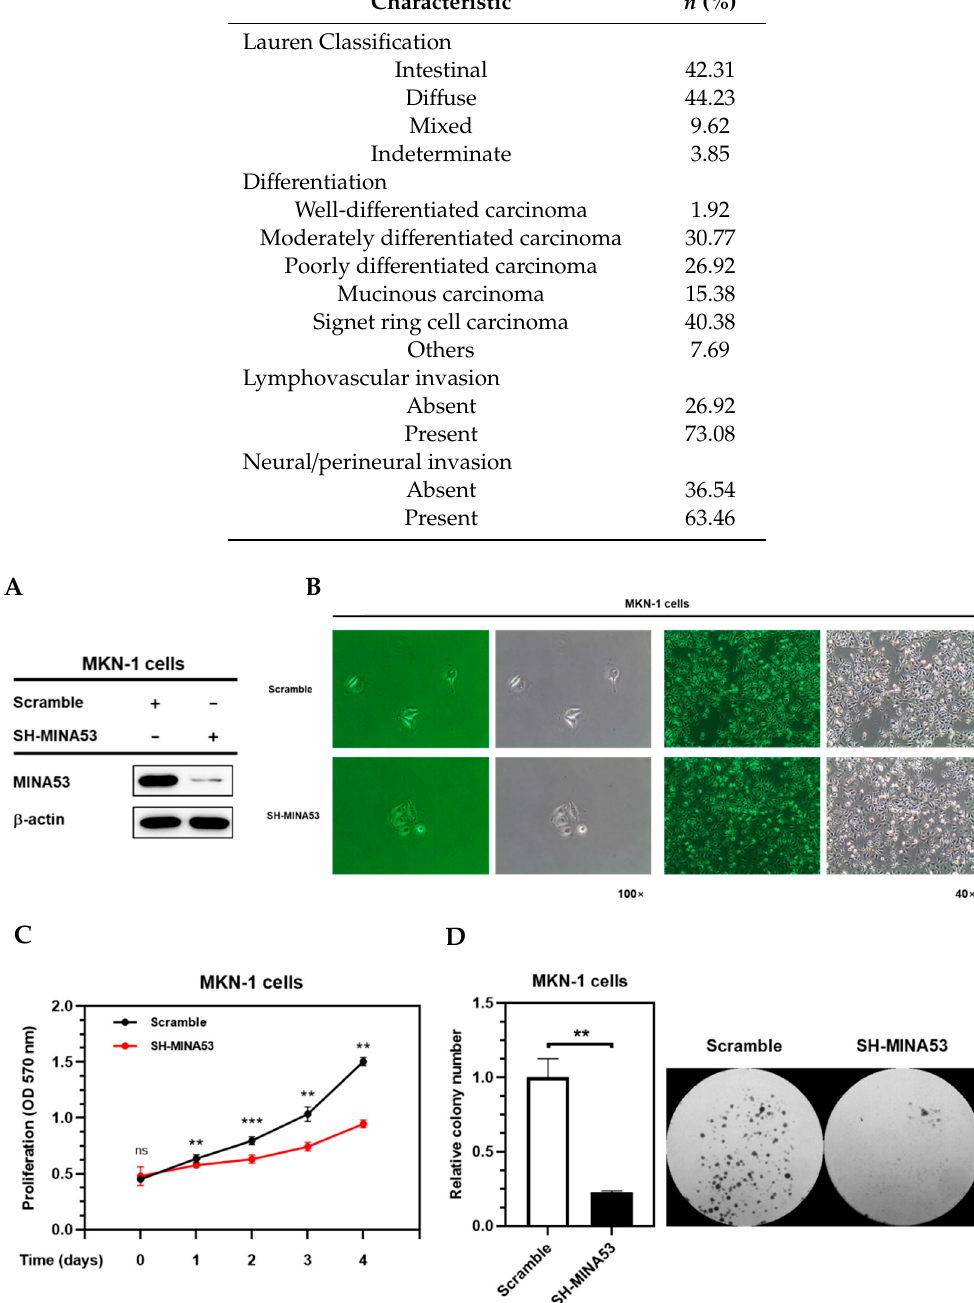
Figure 4. The silencing of MINA53 inhibited proliferation and survival in gastric cancer cell lines. ( A ) Knockdown level of MINA-53 silenced MKN-1 cells. ( B ) Morphology of MINA53-silenced MKN-1 cells compared to scramble MKN-1 cells. ( C ) Proliferation assay of MINA53-silenced MKN-1 cells using MTT assay. ( D ) Colony formation of MINA53-silenced MKN-1 cells after 8 days. The whole Western blot images please find in Figure S1.